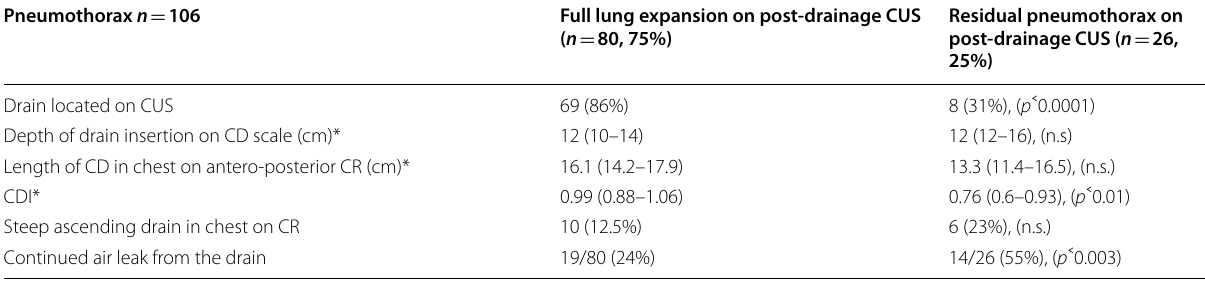
Table1 Comparison of the novel observed categorical parameters (CD location in %, its steep course in %, presence of an air leak in %) and continuous parameters (depth of CD insertion in cm, length of CD in chest in cm, CDI, all * medians and interquartile ranges) between groups with a full lung expansion on CUS (pneumothorax excluded in all lung fields) and group with a